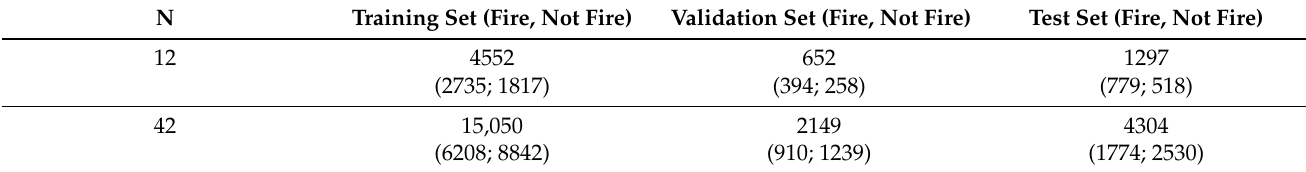
Table 3. Number of images in each sub-set of dataset used for training, validation and testing. N Training Set (Fire, Not Fire) Validation Set (Fire, Not Fire) Test Set (Fire, Not